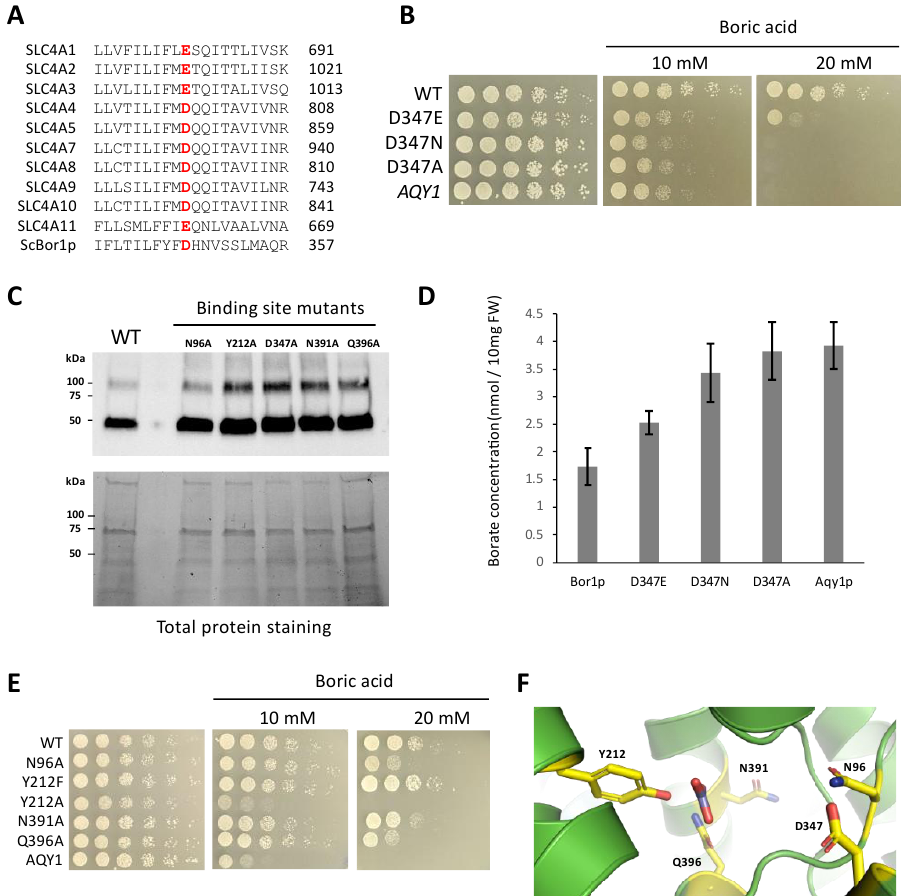
Figure 4. Identification of amino acids important for Bor1p function. ( A ) Multiple sequence alignment of a region of TM8 for all 10 human SLC4 transporters and ScBor1p. ( B , E ) Plasmids encoding the specified ScBor1p mutant were tested against the indicated boric acid concentrations. Plates were incubated at 30 °C and imaged after 5 days. ( C ) Western immunoblotting analysis of His-tagged ScBor1p. (Top) Samples were analyzed with an anti-His6-tag antibody. (Bottom) Total protein stain-free gel imaging of 12μg protein per lane served as loading controls. ( D ) Quantification of borate efflux activity in yeast cells expressing each indicated protein. Intracellular borate contents are reported as nmol per 10 mg fresh weight (FW) of yeast cells. Error bars represent 95% confidence intervals for n = 7 biologically independent experiments. ( F ) View of the solute-binding site of the ScBor1p AlphaFold model with tested amino acids in yellow. Bicarbonate is displayed from a superposed human SLC4A1 structure (RMSD = 3.149 Å).